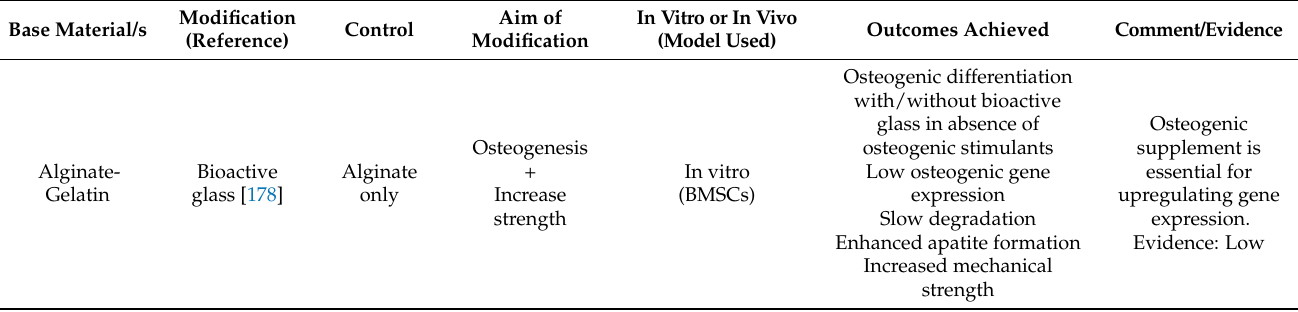
Table 1. Applications of different hydrogels in various in vitro and in vivo bone regeneration